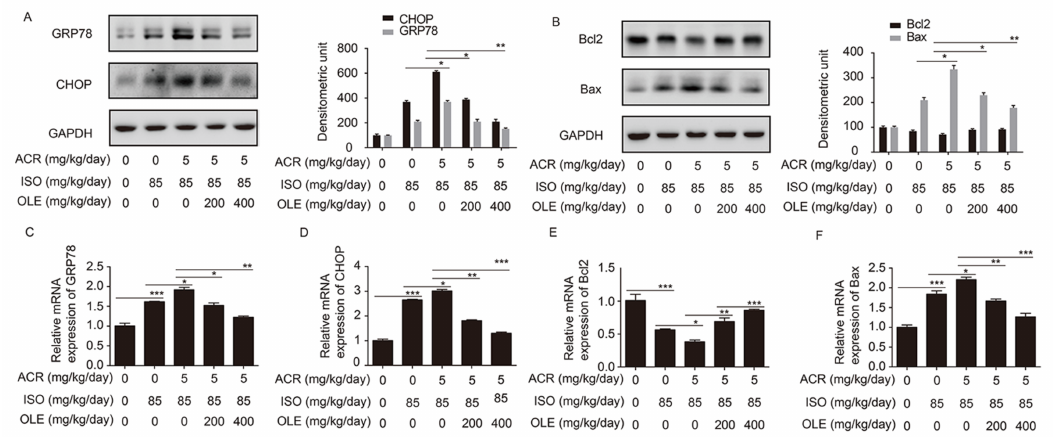
Figure 3. Effect of OLE on myocardium protection through the pathway of ERS, Bcl2/Bax in rats. ( A , B ) The protein expression of GRP78, CHOP, Bcl2 and Bax in different groups, as detected by Western blotting; ( C – F ) The mRNA expression of GRP78, CHOP, Bcl2 and Bax in different groups, as detected by qRT-PCR. * p < 0.05, ** p < 0.01 and *** p <